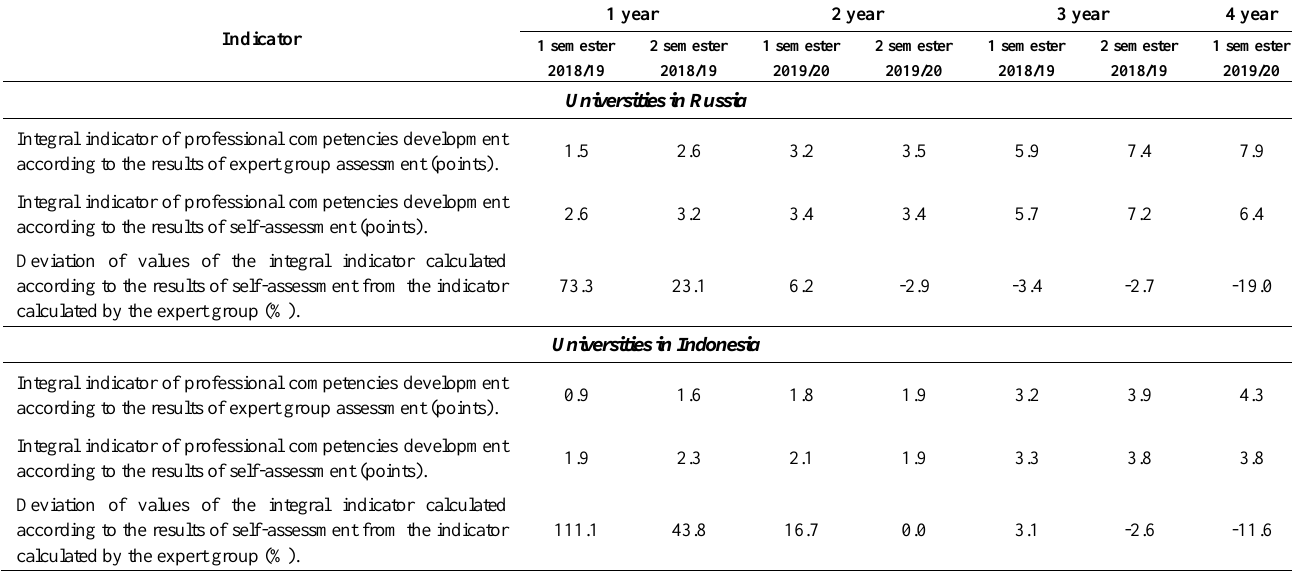
Table 4. Indicators of professional competencies development of students in Russian and Indonesian Universities